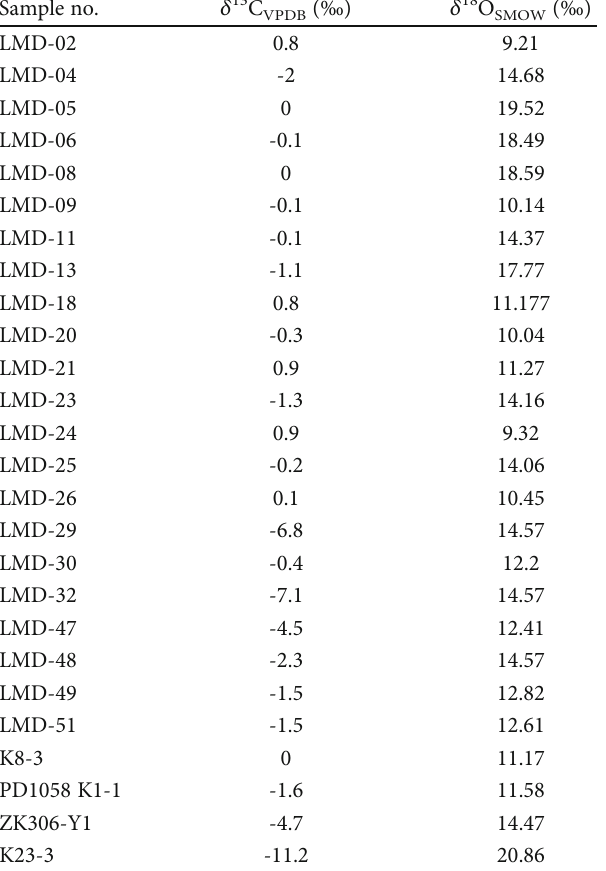
Table 4: C-O isotope data of calcite from the Longmendian Ag-Pb-Zn deposit. Sample no.